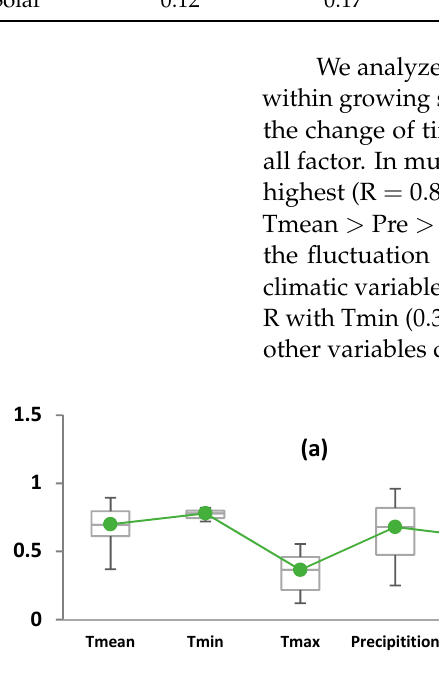
Figure 5. The change in R between NDVI and climatic variable in within-growing season ( a ) and in the inter-growing season ( b ) period 2009–2018.